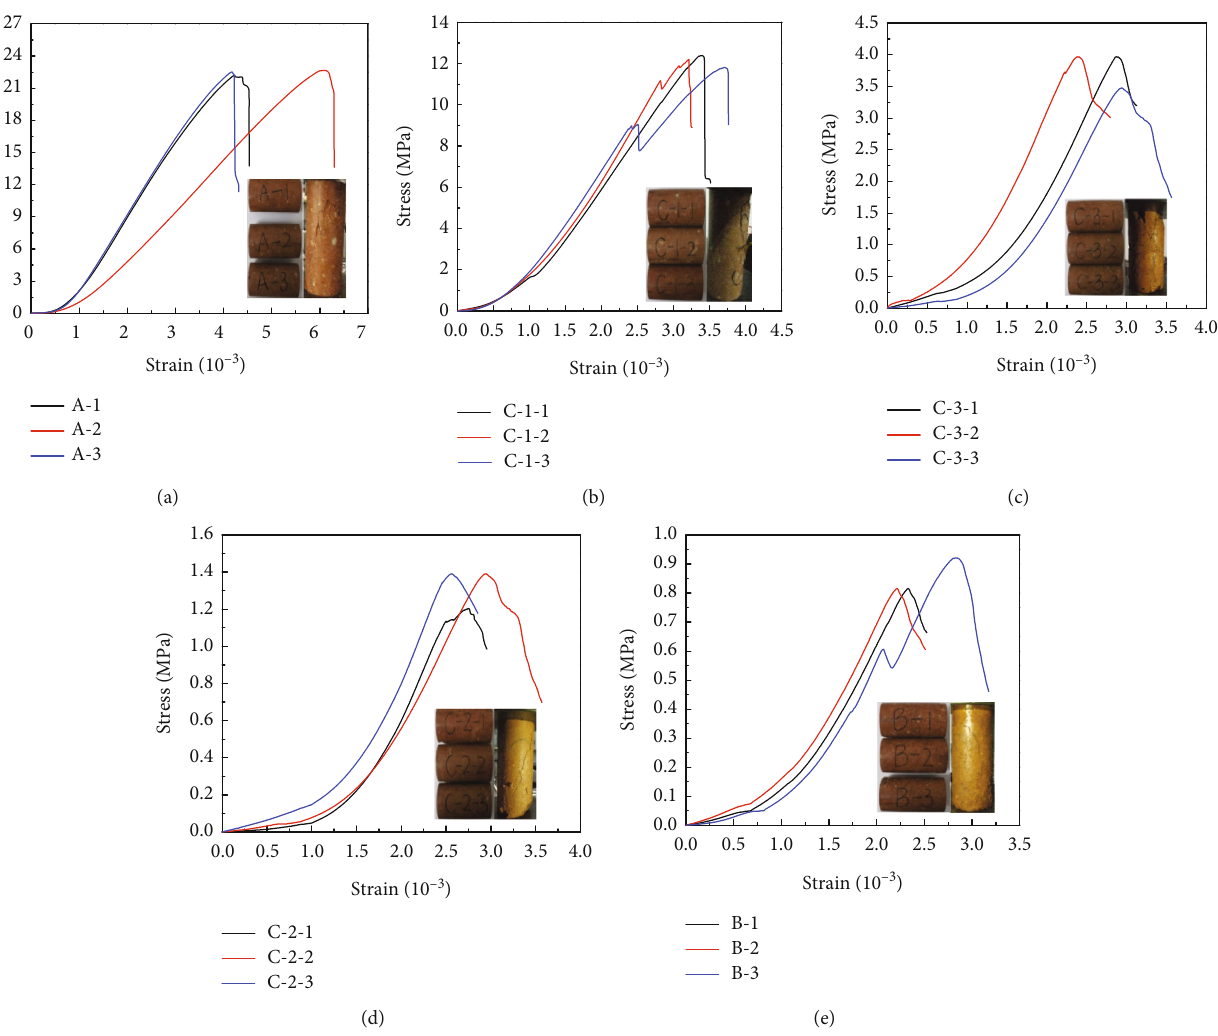
Figure 4: Stress – strain curves of mudstone samples under di ff erent water contents ((a) dry state, (b) 7% water content, (c) 8% water content, (d) 9% water content, and (e) 10% water content (saturated state)). Table 2: Mechanical parameters of mudstone under di ff erent water